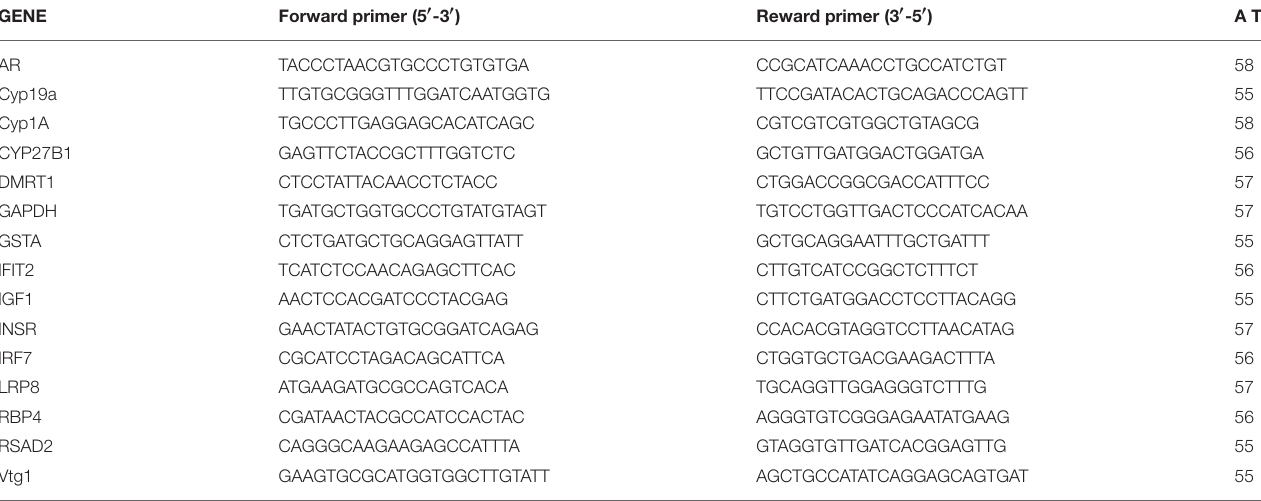
TABLE 1 | List of the primers used in gene expression analysis by quantitative Real-Time PCR. GENE